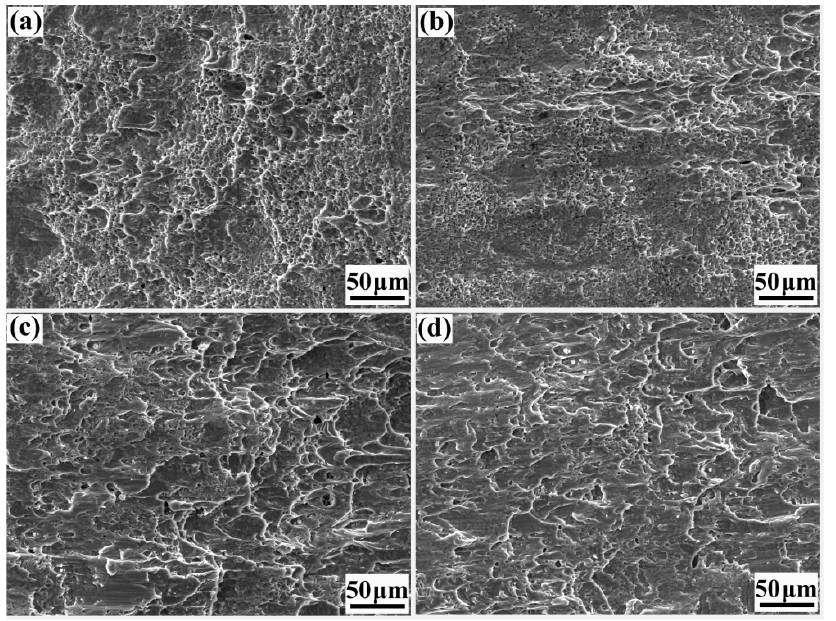
Figure 13. Shear fracture profiles of clad rebars: ( a ) 20MnSiV/316L rebar; ( b ) 35#/316L rebar; ( c ) 45#/316L rebar; ( d ) 55#/316L rebar.